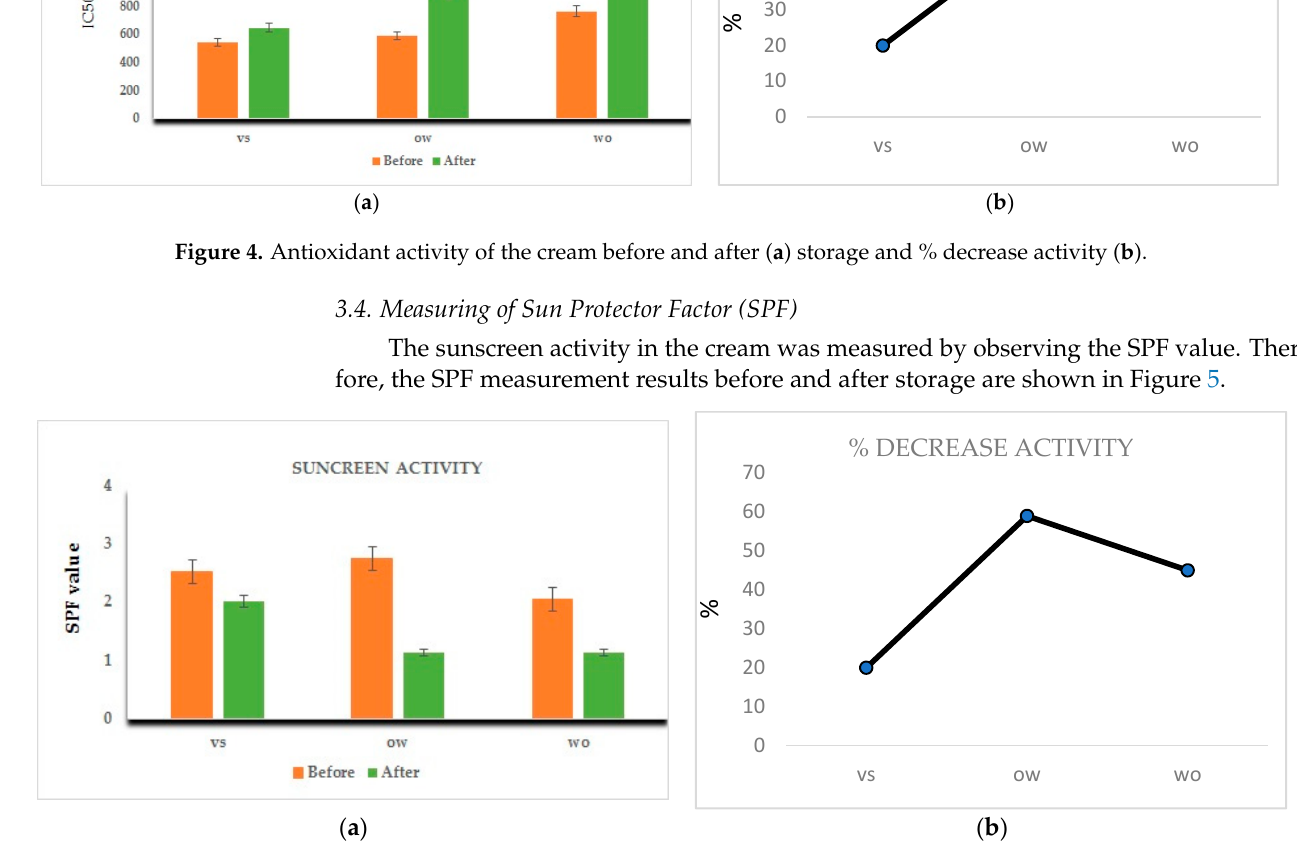
Figure 5. Sunscreen activity of the cream before and after storage ( a ) and % decrease activity ( b )